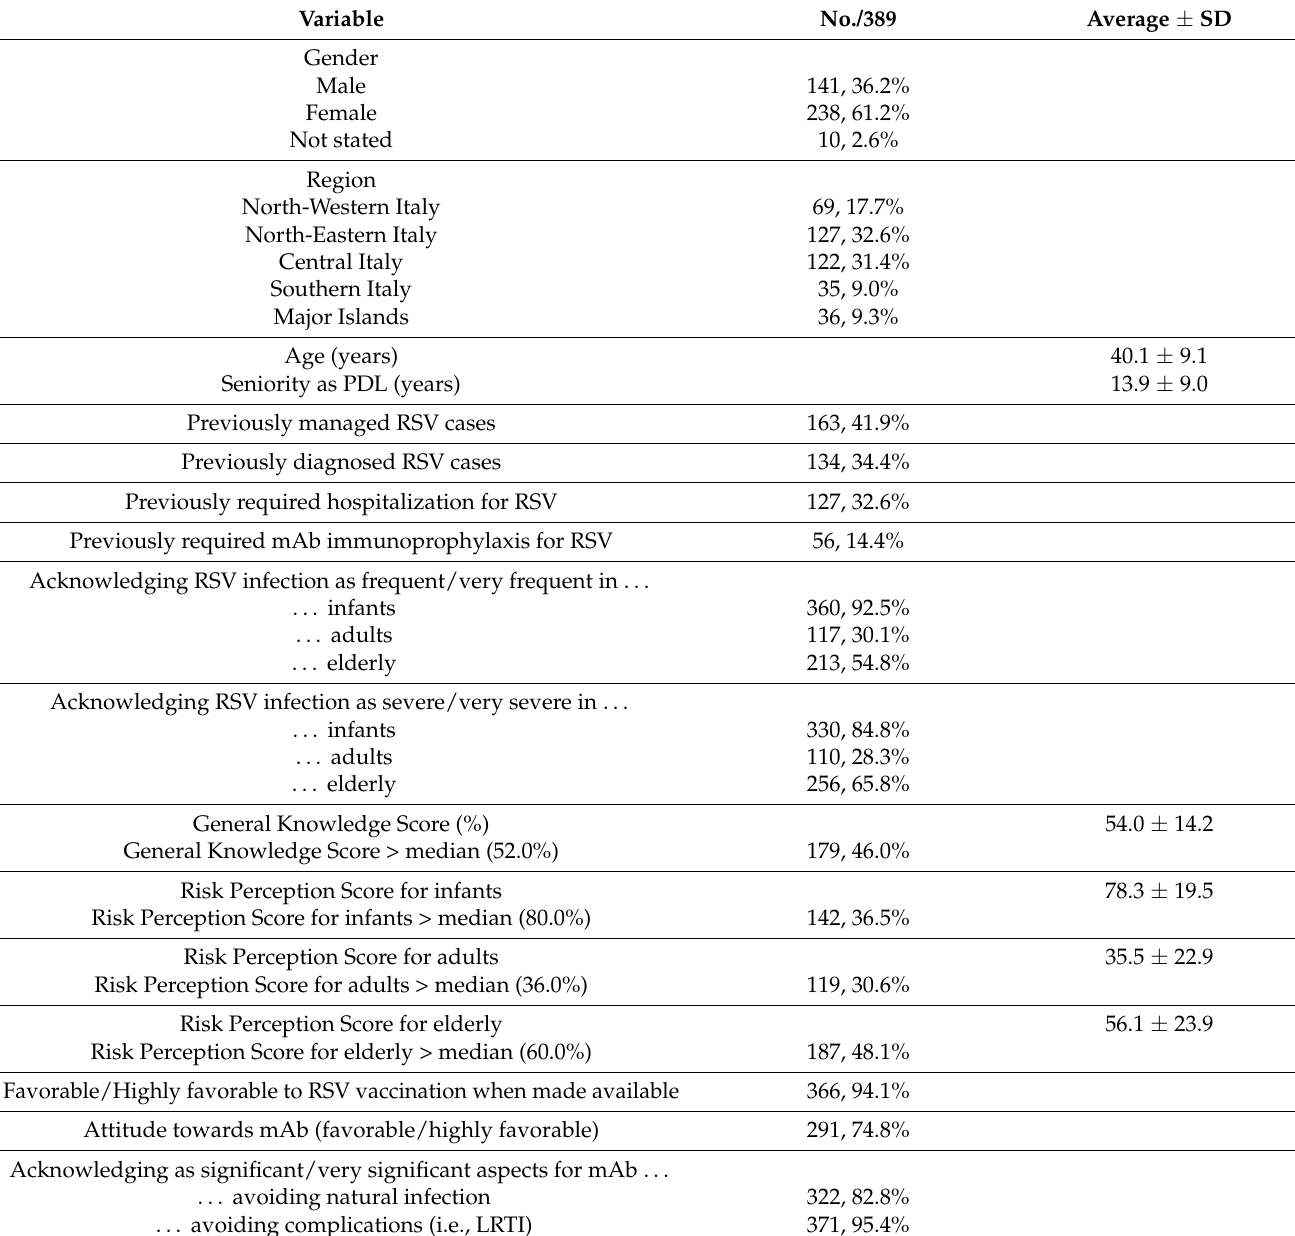
Table 1. Characteristics of the 389 Italian Pediatricians participating into the survey on knowledge, attitudes, and practices on respiratory syncytial